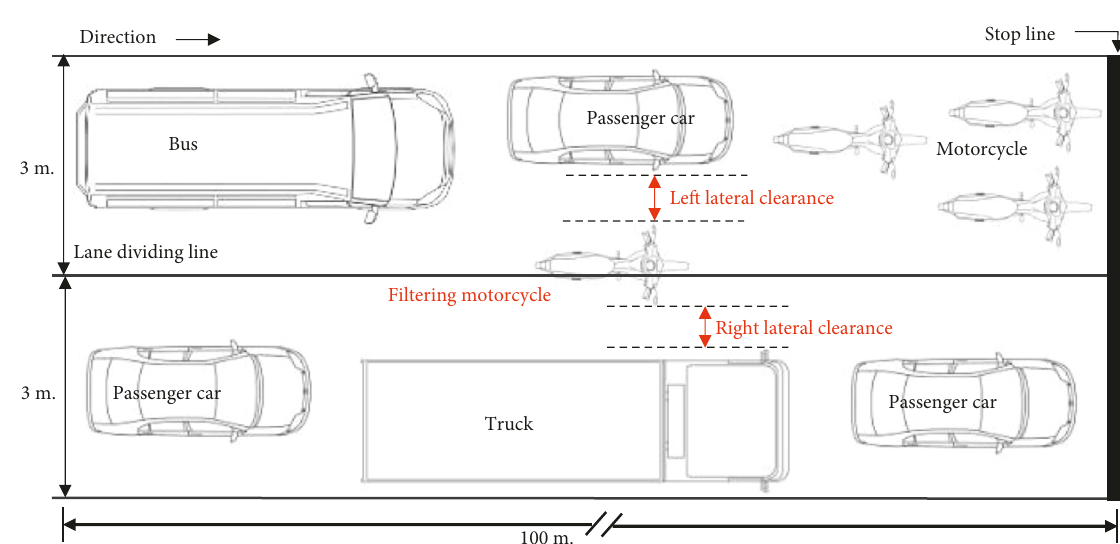
Figure 5: Layout of the study’s eastbound approach.